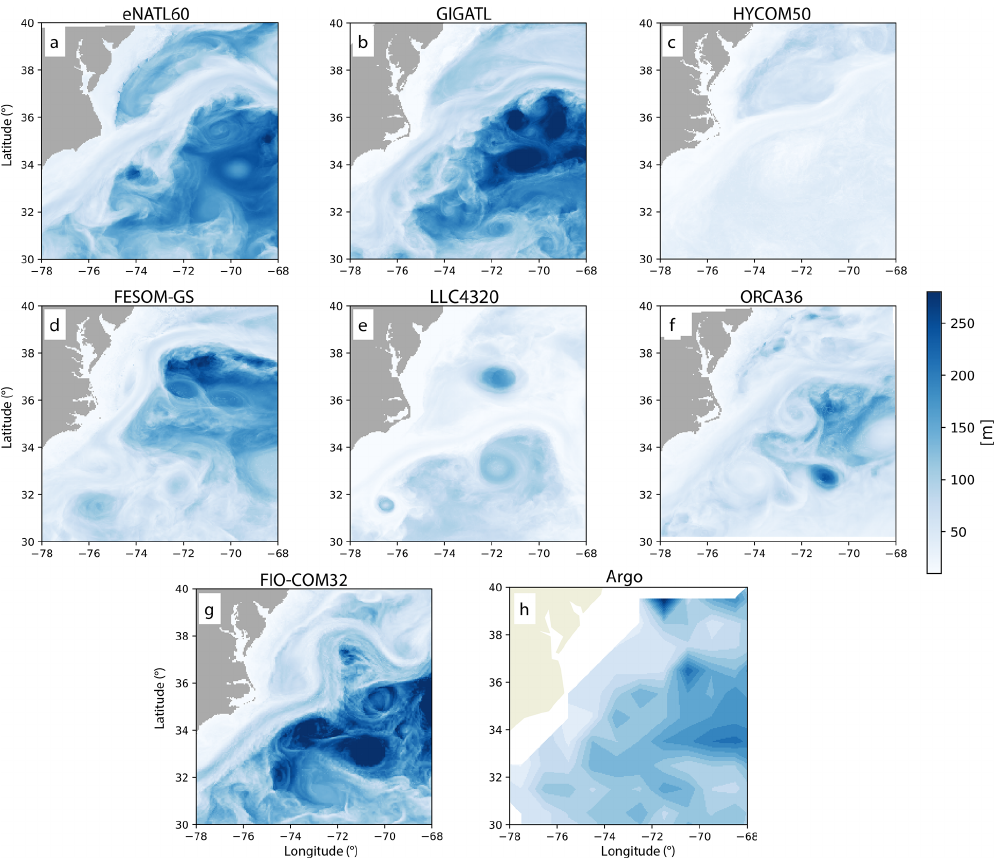
Figure D1. MLD from each model averaged over the duration of 1–15 February when the prediction from the MLI parametrization with a constant C e in HYCOM50 deviates from the diagnosed submesoscale vertical buoyancy flux. The MLD was defined using the density criteria of de Boyer Montégut et al. (2004). For models with non-geopotential vertical coordinates (i.e., GIGATL and HYCOM50), the MLD was computed using their native coordinates, respectively. The climatology for the month of February from the Argo floats is taken from the dataset by Holte et al. (2017). The monthly-mean MLD defined by the density criterion ( mld_dt_mean ) is shown in order to be consistent with our model